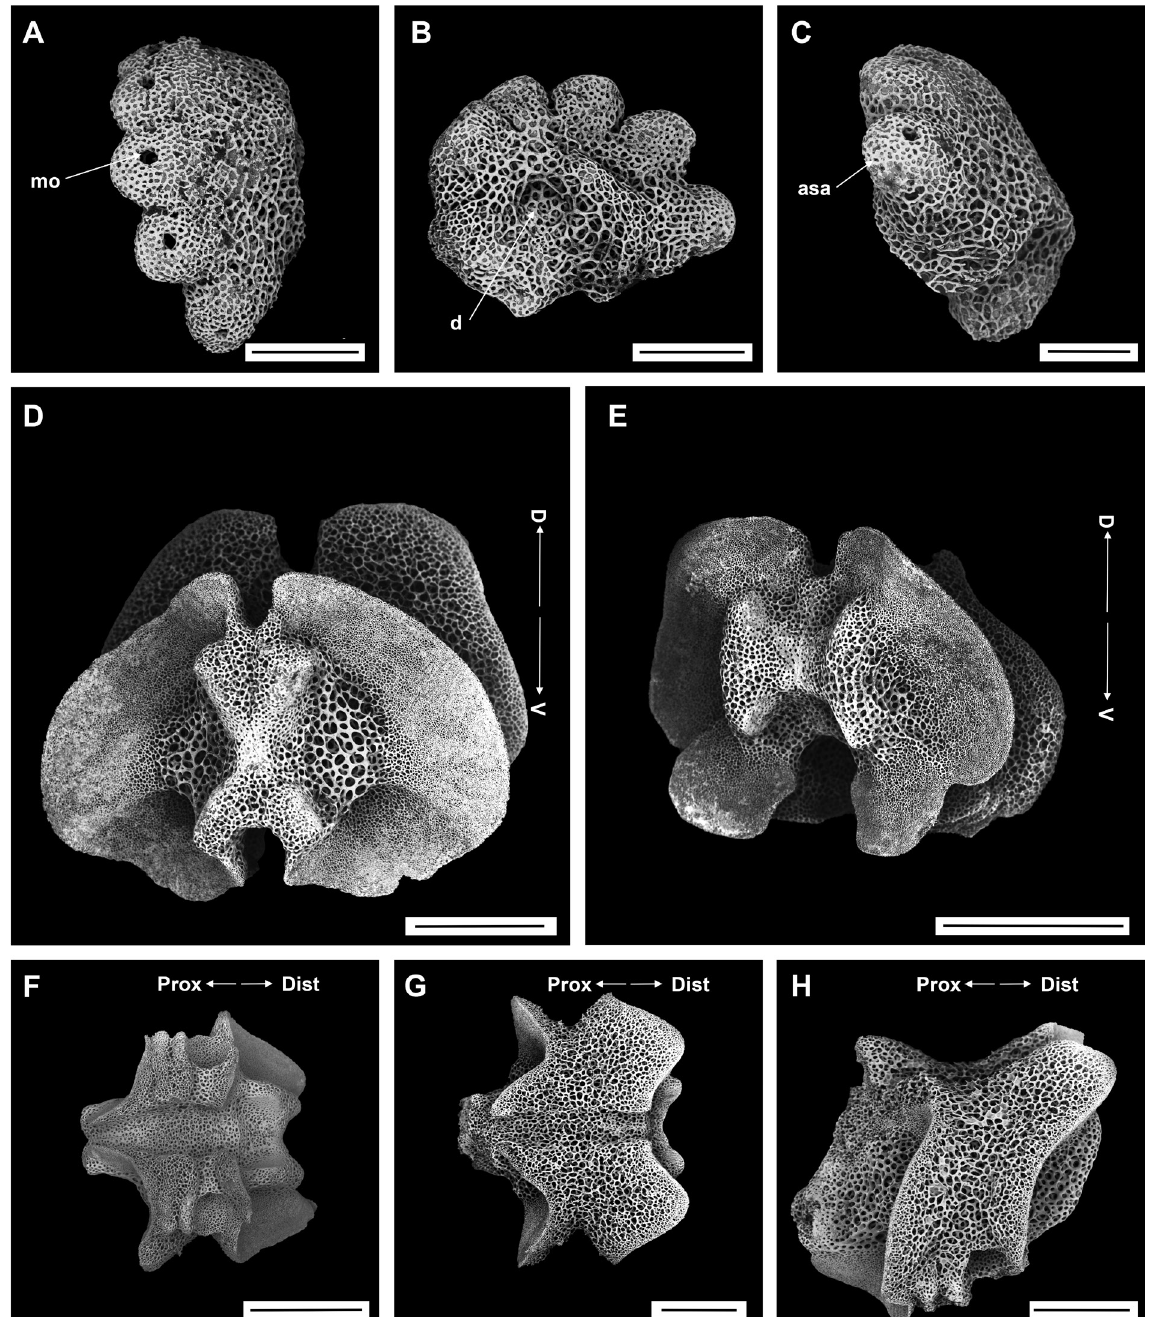
Fig. 6. Asteronyx luzonicus Döderlein, 1927, SEM (IDSSE EEB-SW0003). A–C . Lateral arm plates (internal, external). D–H . Vertebrae. D . Proximal view. E . Distal view. F . Ventral view. G . Dorsal view. H . Lateral view. Abbreviations: asa = arm spine articulation; D = dorsal; d = depression; Dist = distal; mo = muscle opening; Prox = proximal; V = ventral. Scale bars: A–B = 300 µm; C = 200 µm; D, G–H = 500 µm; E–F = 800